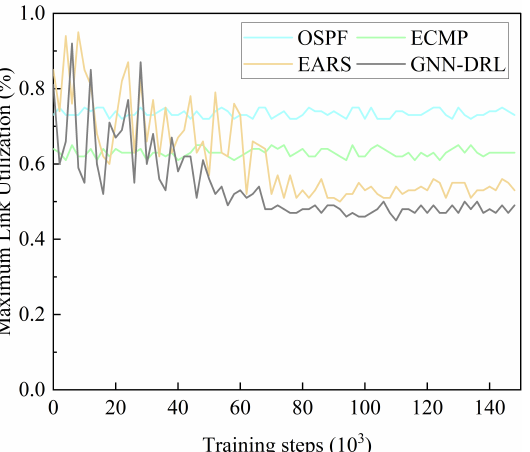
Figure 7. Optimization effect of maximum link utilization under 80 Mbps traffic